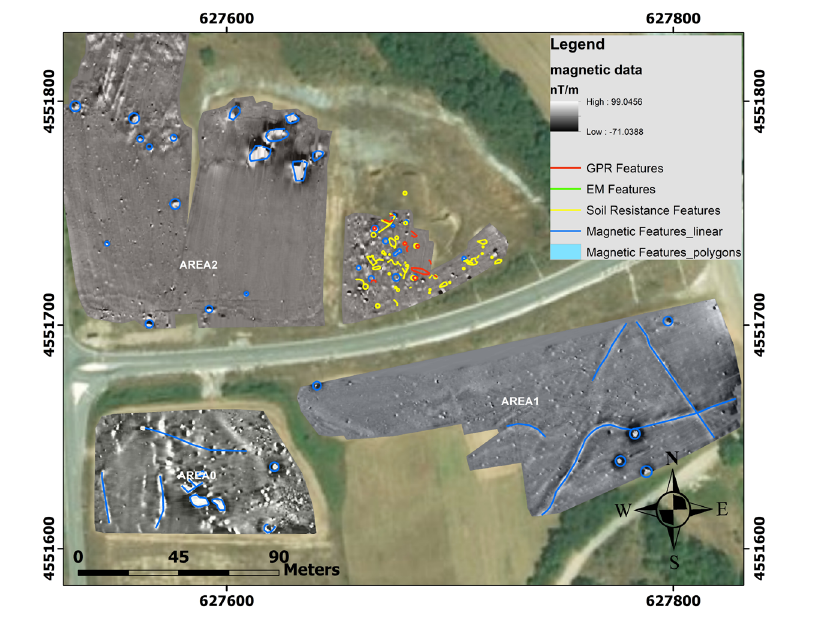
Figure 11. Further structural features detected by the geophysical investigation in the area close to the Neolithic site (EGSA 1987, Greek national